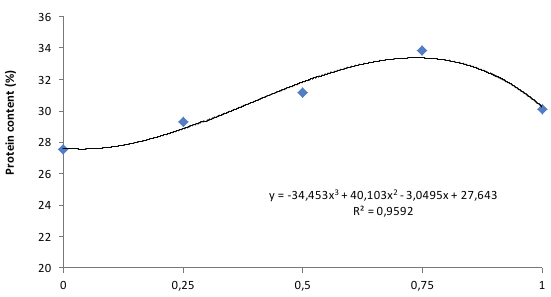
Figure 1 - The effect of different concentrations of nano-iron oxide on soybean seed protein content.